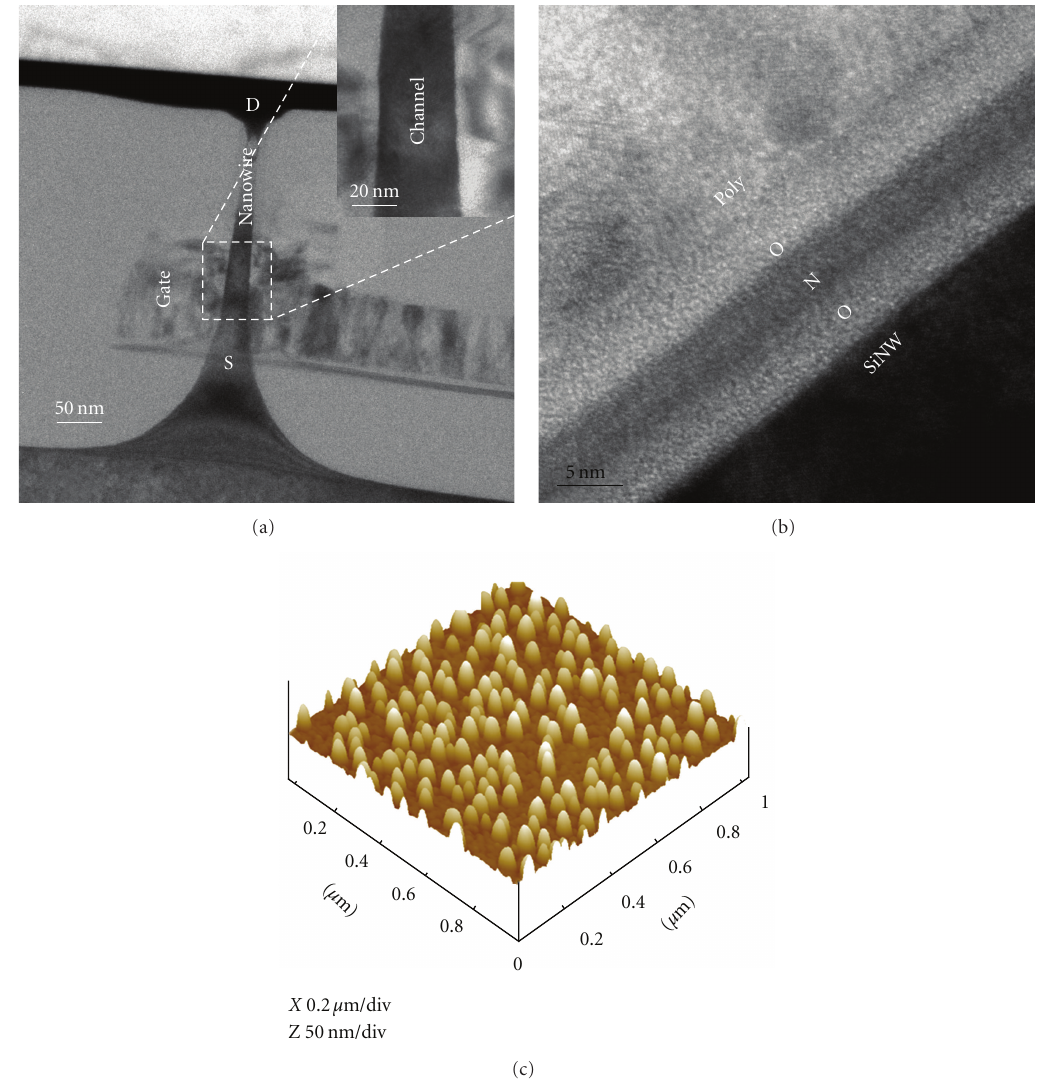
Figure 12: (a) Cross-sectional TEM image of vertical SiNW GAA JL-SONOS: diameter of wire is 20 nm and gate length 120 nm, (b) Cross- sectional TEM image of gate stack showing ONO thickness 5/7/7 nm. (c) AFM image scanned on 1 × 1 μ m 2 surface area that reveals the formation of Si-NC with a density of 7.5 × 10 10 /cm − 2 . (Reprinted with permission from [45]. [2011]